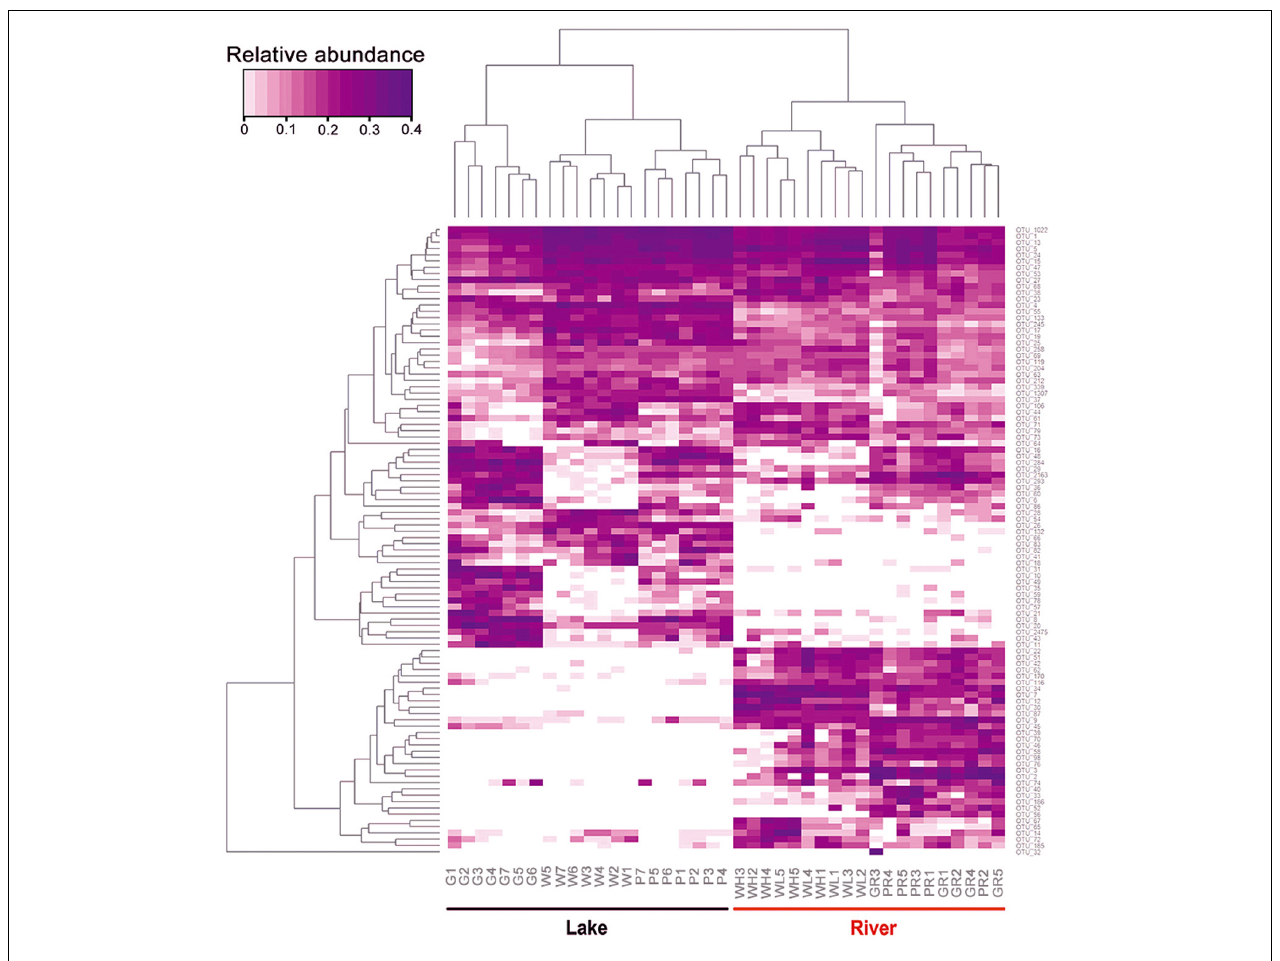
FIGURE 6 | Relative abundance of top 100 microeukaryotic OTUs with most abundant read counts. Samples are labeled in lateral axis, and abundance of each OTU is labeled in vertical axis. The phylogenetic tree was calculated using neighbor-joining method, and the relationship among samples was determined by Bray distance. The relative abundance for each OTU was depicted by color intensity with the legend indicated at the left top of the figure. Samples are named as follows: G, glass slides in Ming Lake; P, PFUs in Ming Lake; W, water columns in Ming Lake; GR, glass slides in Pearl River; PR, PFUs in Pearl River; WH, water columns at high tide in Pearl River; WL, water columns at low tide in Pearl